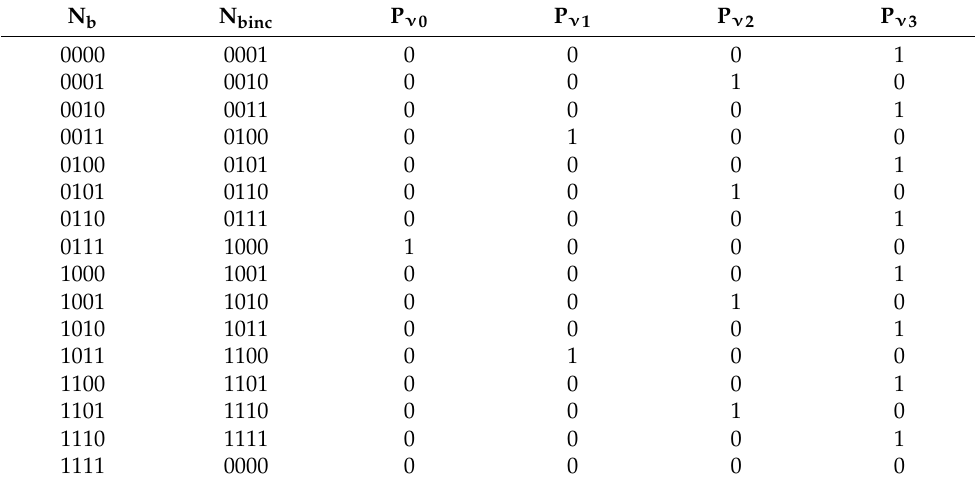
Table 1. Example of obtaining bit